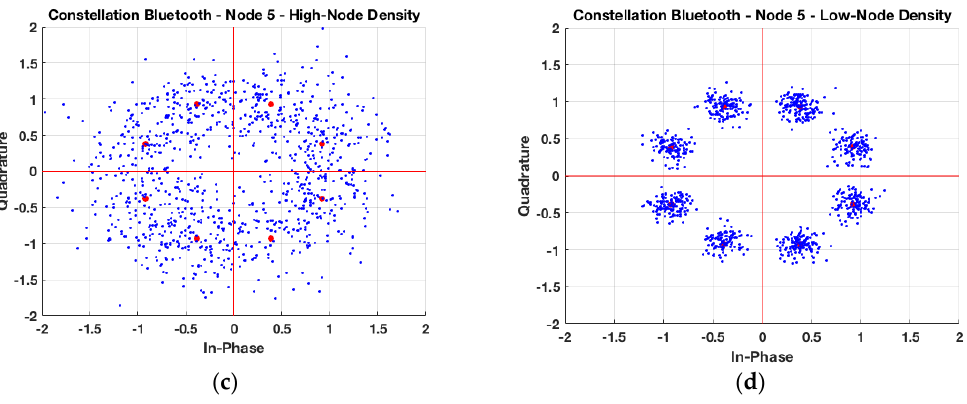
Figure 9: In Phase and Quadrature representation for two different nodes within the auditorium for 8-DPSK modulation, ( a ) indoor node with high-node density scenario, ( b ) indoor node with low-node density scenario, ( c ) outdoor node with high-node density scenario, and ( d ) outdoor node with low-node density scenario. Table 3. EVM (%) for different nodes-density cases for the Bluetooth V4.0 system.